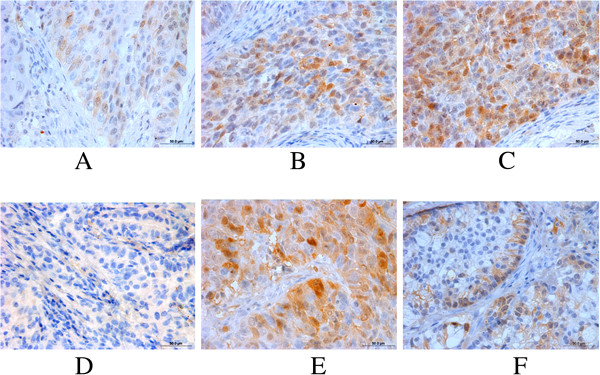
Enhanced expression of TS protein in NSCLC compared with the corresponding normal tissues. Paraffin sections from patients with NSCLC were prepared and stained with anti-TS antibody and then reviewed and scored under a microscope. A-C, Representative low, medium, and high levels of TS expression, respectively. D, Negative staining of normal tissues. E, strong expression of TS protein in lung squamous cell carcinoma. F, low level of TS expression in lung adenocarcinoma.